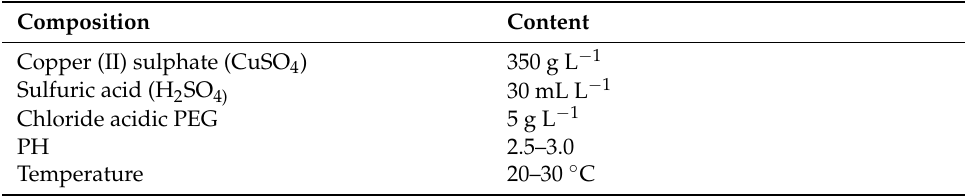
Table 2. Electroplating conditions for the conductive layer